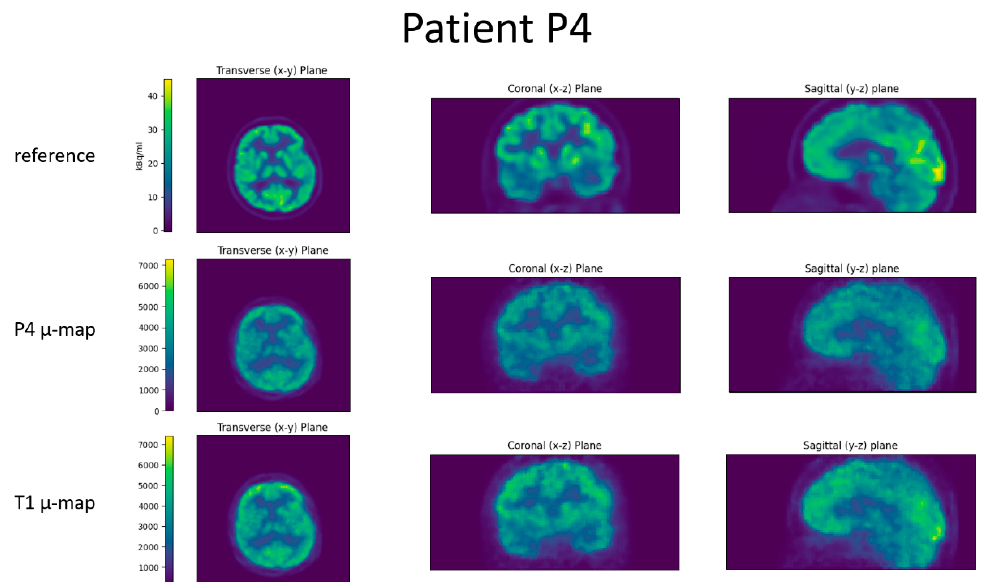
Figure 9. Slices through the reconstructed images for patient P4. Top row is the reference PET scan, middle row the BPET reconstruction using the patient-specific µ-map (from CT of patient P4), bottom row the BPET reconstruction using an independent template µ-map fitted with the method presented in this article.